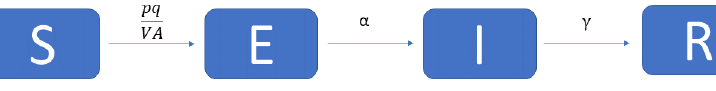
Figure 1. SEIR-GN